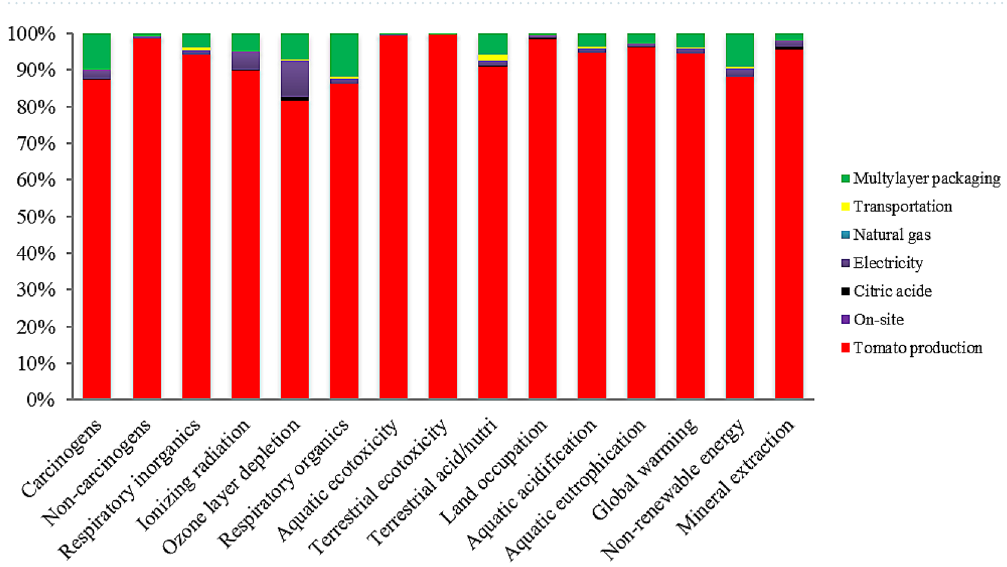
Figure 3. Inputs contribution to the environmental impact of tomato juice production upon appertization.